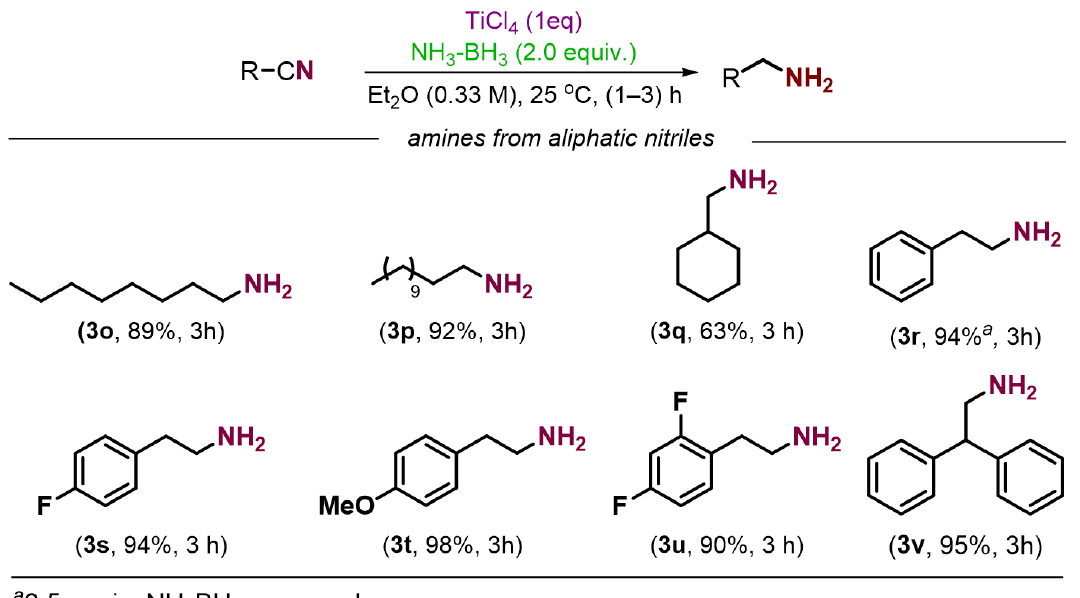
Figure 3. Reduction of activated aliphatic nitriles with ammonia borane.